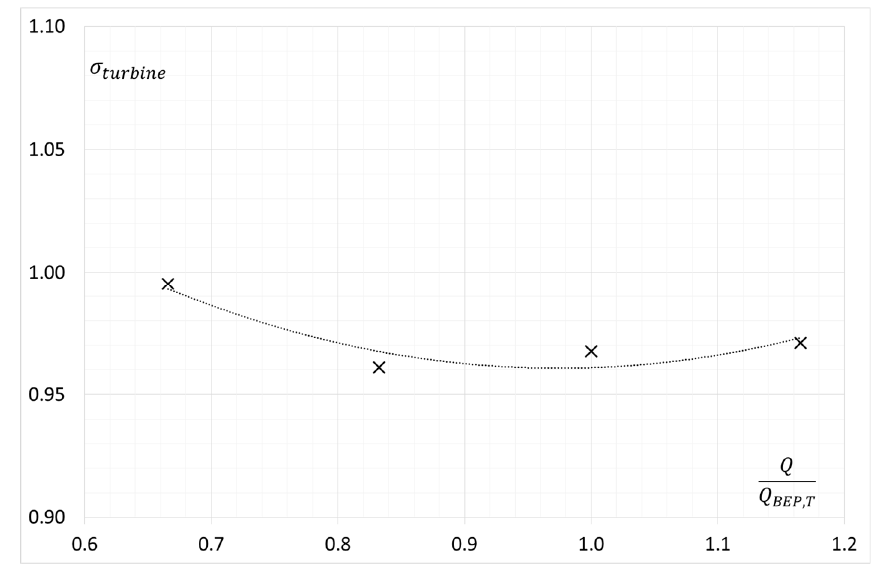
Figure 21. Slip factor in turbine mode, σ (cid:3047)(cid:3048)(cid:3045)(cid:3029)(cid:3036)(cid:3041)(cid:3032) , vs flow rate ratio, 𝑄 𝑄 (cid:3003)(cid:3006)(cid:3017),(cid:3021) ⁄ .